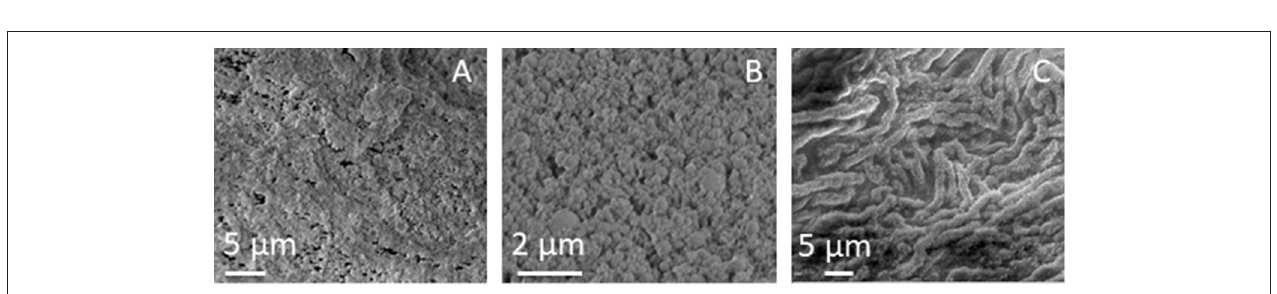
FIGURE 3 | (A,B) SEM images of SUNSPACE, reported at different magnifications and 3 (C) SEM image of the Hedera Helix L . leaf surface.